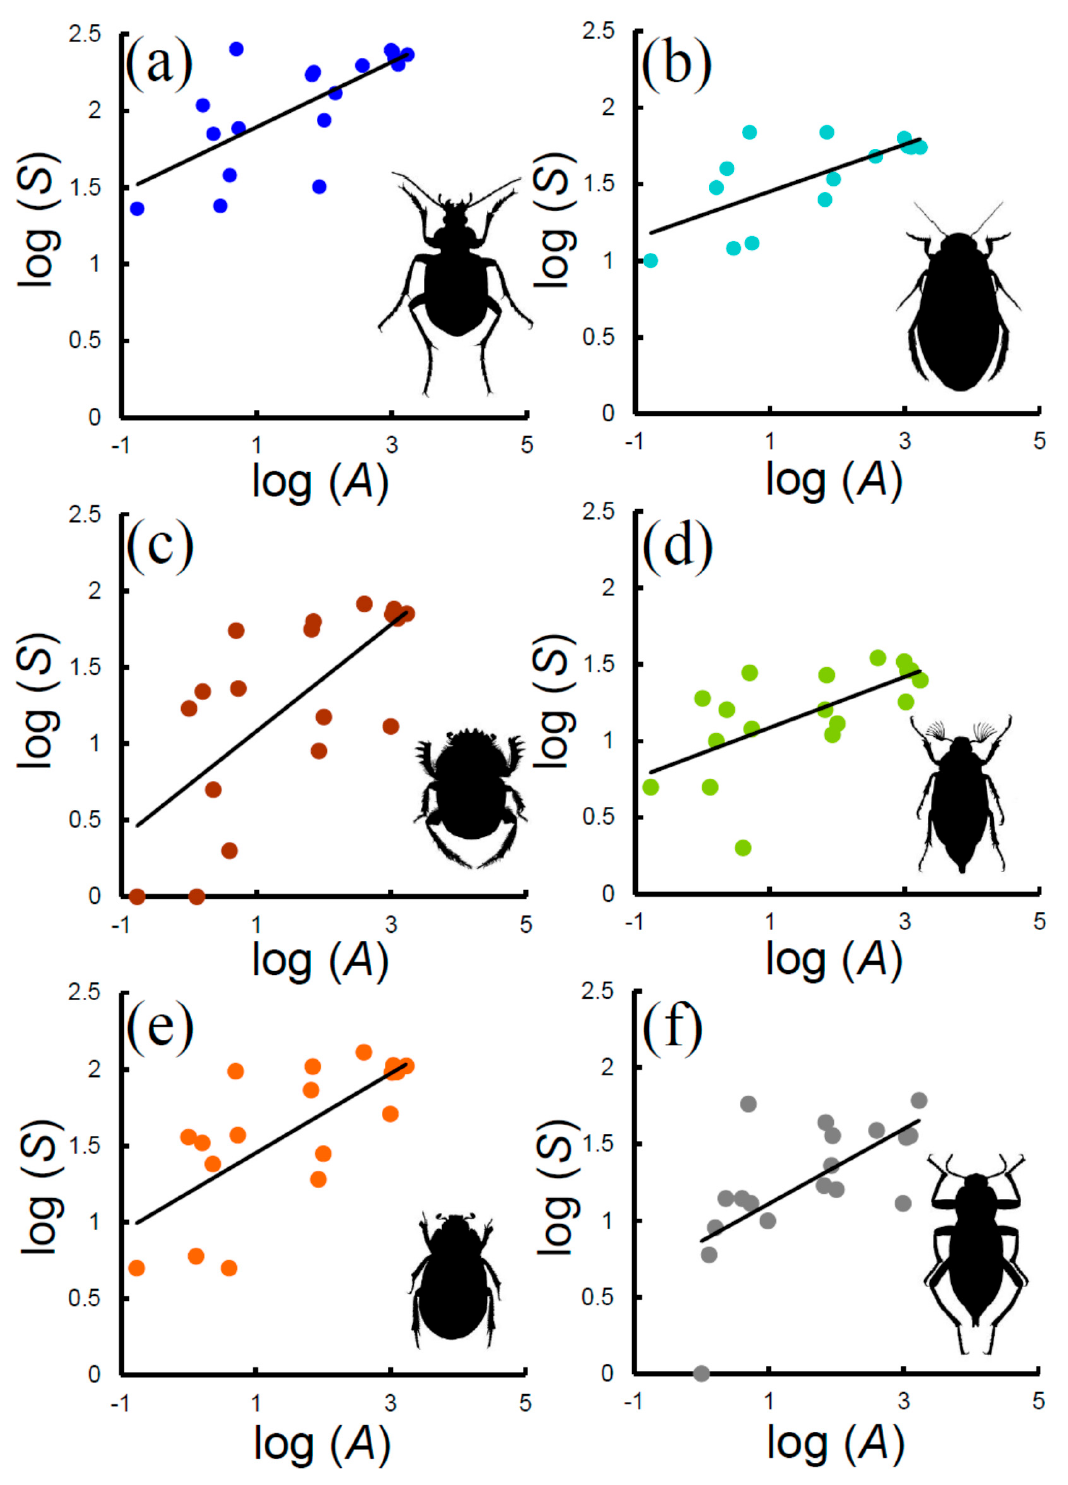
Figure 2. Species–area relationships (SARs) for various beetle groups in Italian reserves: ( a ) Carabidae, ( b ) Hydradephaga, ( c ) coprophagous Scarabaeoidea, ( d ) phytophagous Scarabaeoidea, ( e ) total Scarabaeoidea, ( f ) Tenebrionidae. Decimal logarithms are used. Table 2. Species – area relationships (SARs) for beetles in Italian reserves. SARs were modelled using the linearized version of the power function with decimal logarithms: log( S ) = log( c ) + z log ( A ), where